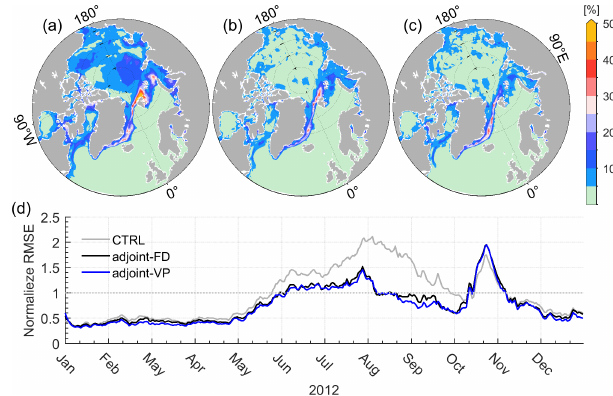
Figure 3. Root mean square errors (RMSEs) of SIC between the satellite measurements and (a) the control run, (b) adjoint-FD, and (c) adjoint-VP averaged over 2012. Panel (d) shows the temporal variations in RMSEs normalized by prior uncertainties in the three simulations averaged over the regions covered by sea